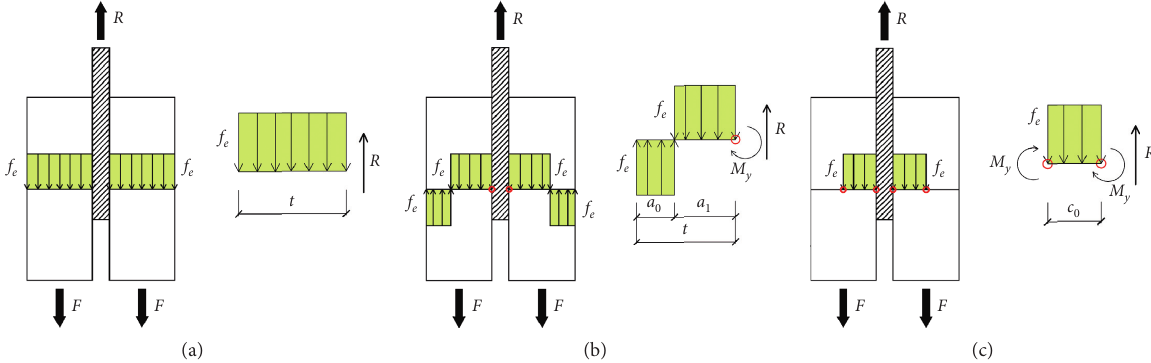
Figure 6: The stress distributions under three different yield modes. (a) Mode I. (b) Mode II. (c) Mode